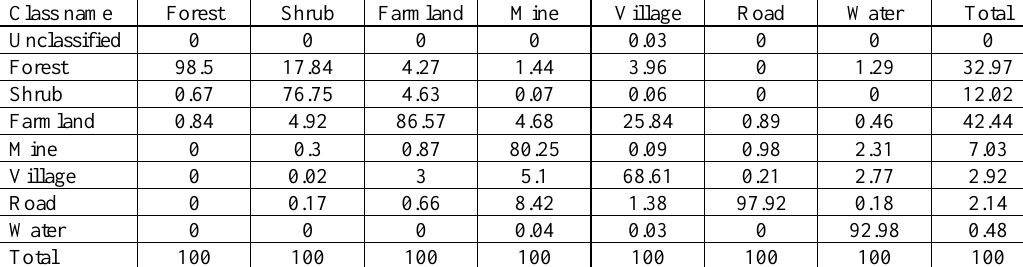
Table 3. Accuracy assessment of Model 4